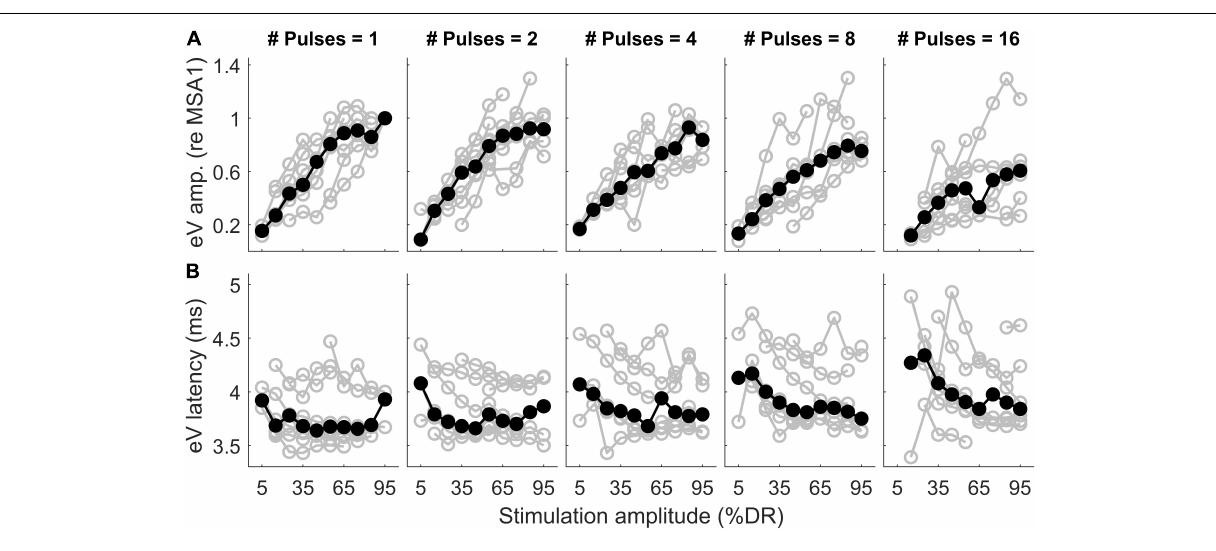
FIGURE 11 | Wave eV amplitude growth functions (A) and latency functions (B) as a function of stimulation amplitude in all MP conditions for 8 ears (last column of Table 1 ). The amplitude data was normalized to the largest valid wave eV amplitudes in the 1-pulse condition for each ear. Results from individual subjects are plotted in open gray circles, while the corresponding median values are plotted in filled black